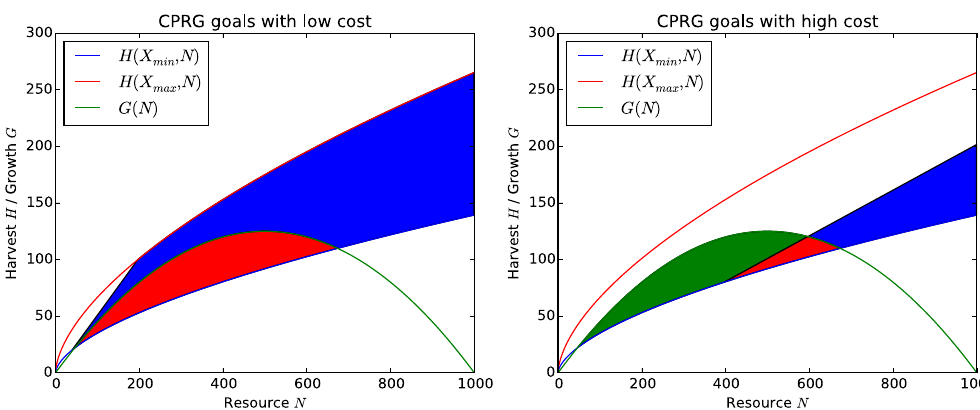
Figure 5. The influence of cost on resource dynamics and the ability to harvest profitably and sustainably. ( a ) A CPRG setup with cost c = 0.2; almost any action becomes profitable, but only a subset of actions is sustainable. Agents will not be able to distinguish between the two anymore and start overharvesting. ( b ) A CPRG setup with cost c = 0.8; the set of actions that are both profitable and sustainable becomes very small. Agents will not be able to make profits as they need to maintain the resource at a high